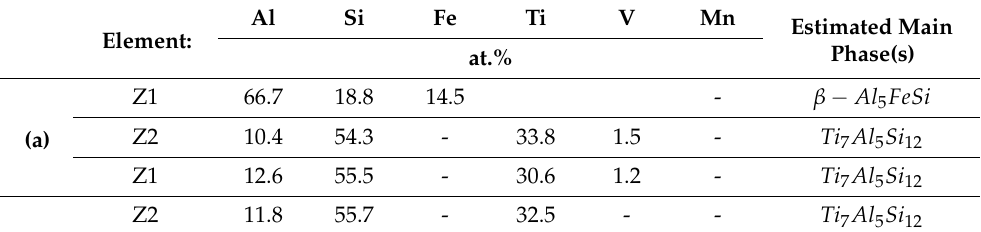
Table 3. EDS points analyses for the joint 13/680 presented in Figure 23.